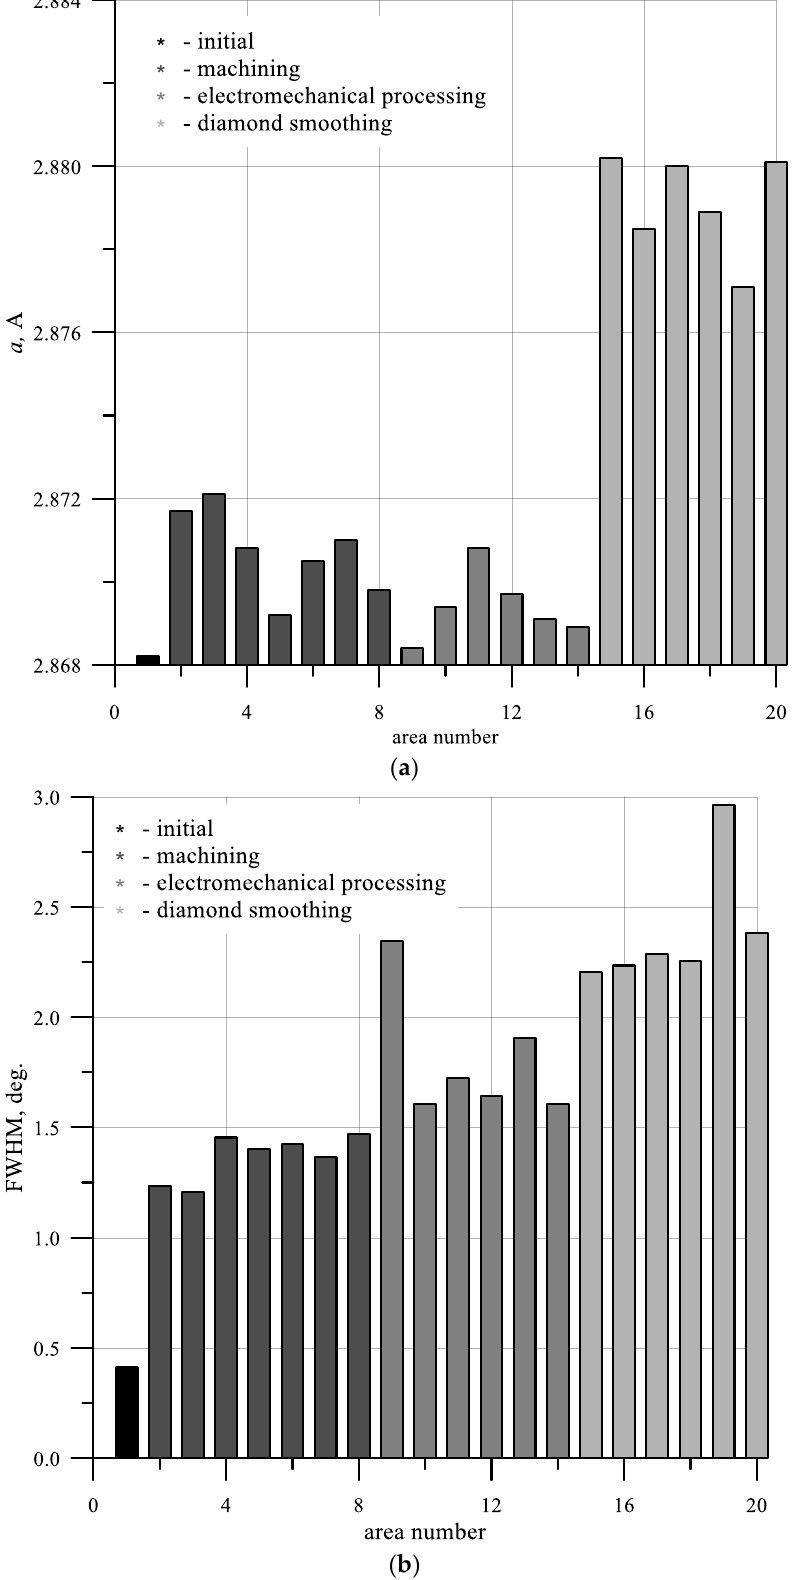
Figure 6. The dependence of the lattice parameter ( a ) and the half-width of the X-ray line ( b ).